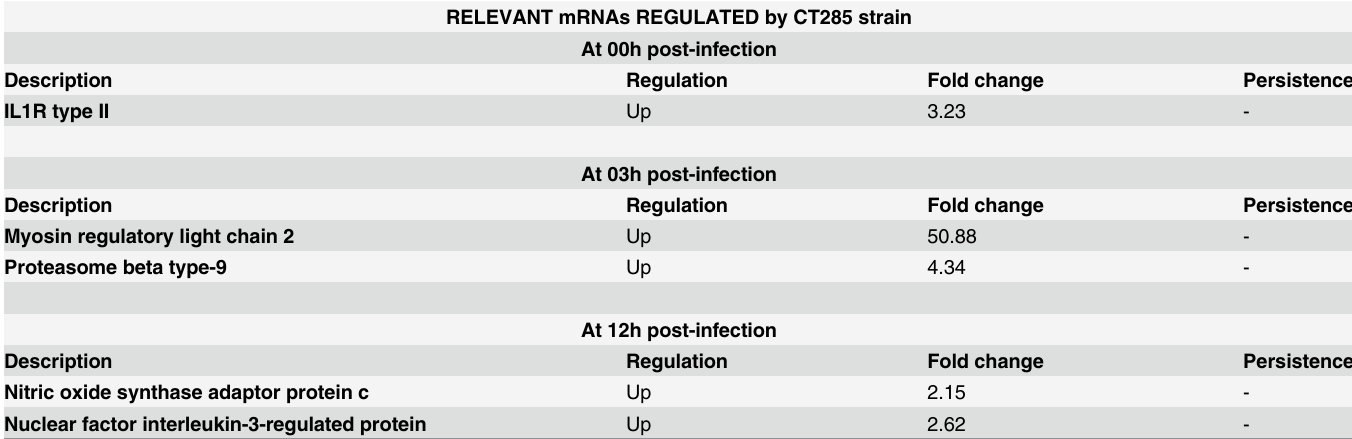
Table 4. List of relevant immune-related mRNAs regulated during V . vulnificus CT285 infection by loop analysis. Asterisk ( * ) represents relevant mRNAs with FC < 2, however with statistically significant difference (p < 0.05). RELEVANT mRNAs REGULATED by CT285